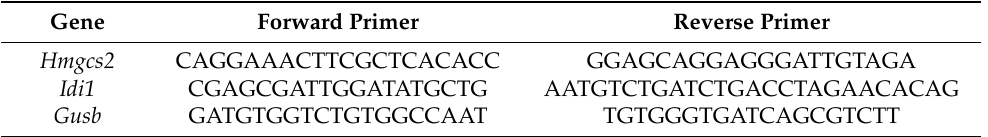
Table 2. Primer sequences for real-time